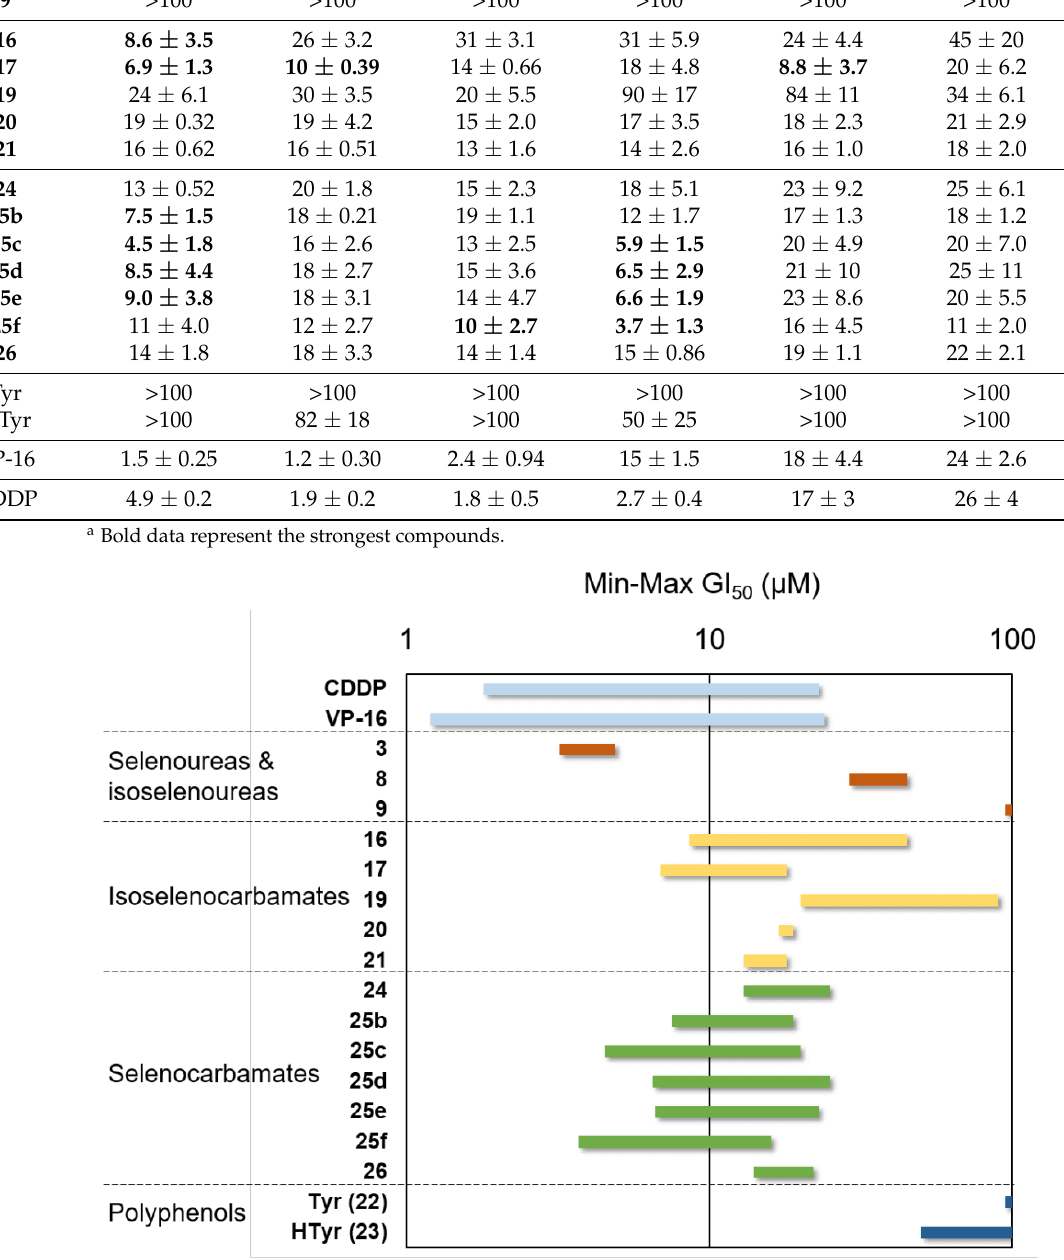
Figure 2. GI 50 range plot of selenoureas, isoselenoureas, isoselenocarbamates and selenocarbamates against human solid tumour cell lines. Cyan: reference drugs; red: selenoureas & isoselenoureas; yellow: isoselenocarbamates; green: selenocarbamates; blue: polyphenols.